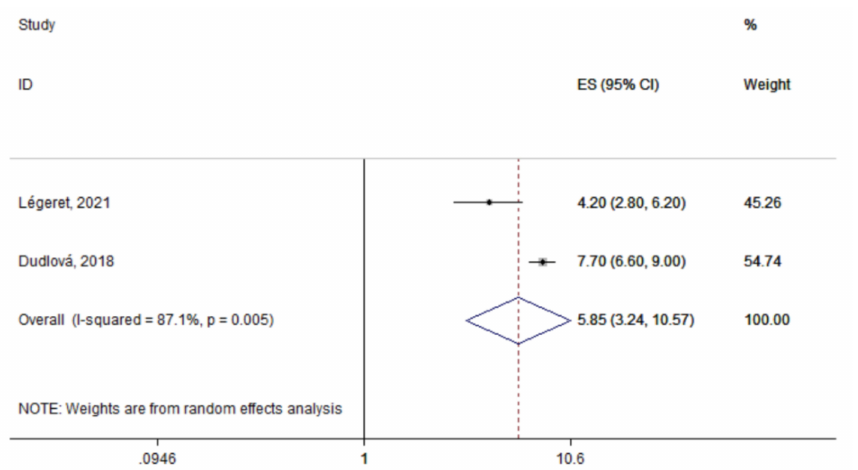
Figure 2. Forest plot of the summary prevalence of intestinal parasitic infections in children residing in Europe (2015–2021). Prevalence ratios of individual studies are indicated by the data markers; shaded boxes around data markers reflect the statistical weight of the study; 95% confidence intervals (CI) are indicated by the error bars; summary-effect estimates with their 95% CI are depicted as a